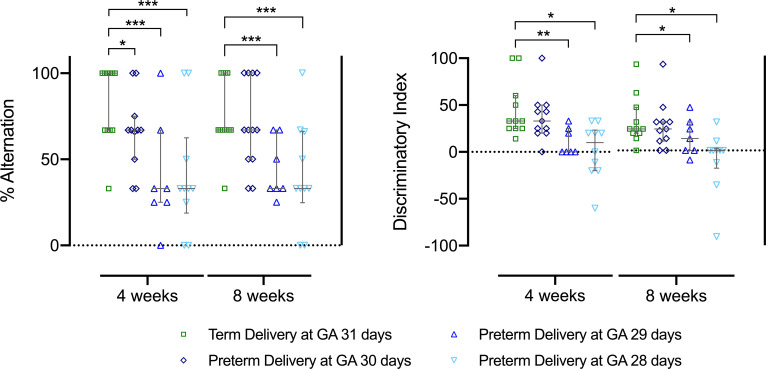
Rabbit neurobehavioral assessment on corrected postnatal age of 4 and 8 weeks.Spontaneous alternation percentage in the T-Maze test (A) and righting reflex events (B). PCA31d n = 11, PCA30d n = 11, PCA29d n = 7 and PCA28d n = 10. Data displayed as median and IQR with significance compared to the term birth group indicated as * 0.05 ≥ p > 0.01; ** 0.01 ≥ p > 0.001; ***p < 0.001.